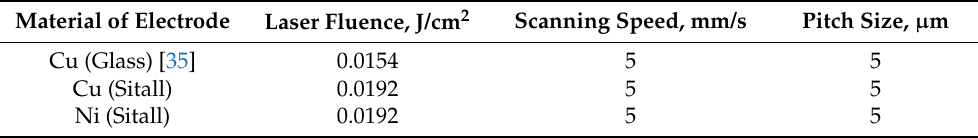
Table 2. The optimized SLS experimental conditions used for synthesis of Cu and Ni on glass- ceramics surfaces.